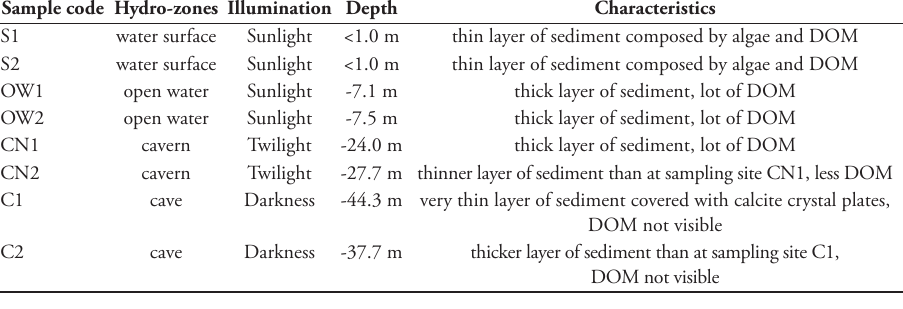
Table 1. Data of the sampling sites and characteristics of sediment samples collected from four zones of cenote X-Batún. DOM = decaying organic matter.